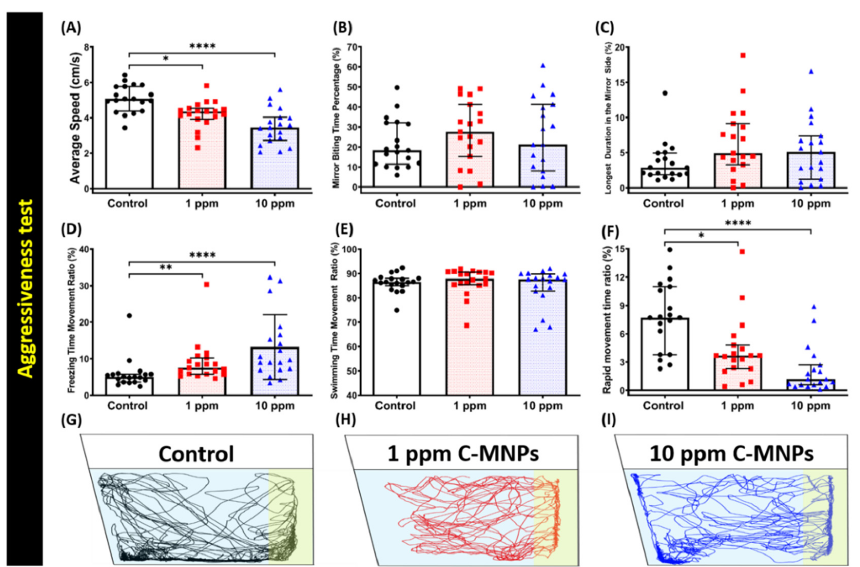
Figure 3. Biting behavior endpoint comparisons between the control group, 1 ppm, and 10 ppm C-MNPs-exposed zebrafish groups after two weeks of exposure. ( A ) Average speed ( B ) mirror biting time percentage ( C ) longest duration in the mirror side ( D ) freezing time movement ratio ( E ) swimming time movement ratio, and ( F ) rapid movement time ratio were analyzed. ( G–I ) The 5 min locomotor trajectories of control, 1 and 10 ppm C-MNPs-exposed fish in the mirror biting test. The data are expressed as the median with interquartile range and were analyzed by the Kruskal-Wallis test continued with Dunn’s multiple comparisons test as a follow-up test ( n = 20, * p < 0.05, ** p < 0.01, **** p < 0.001).